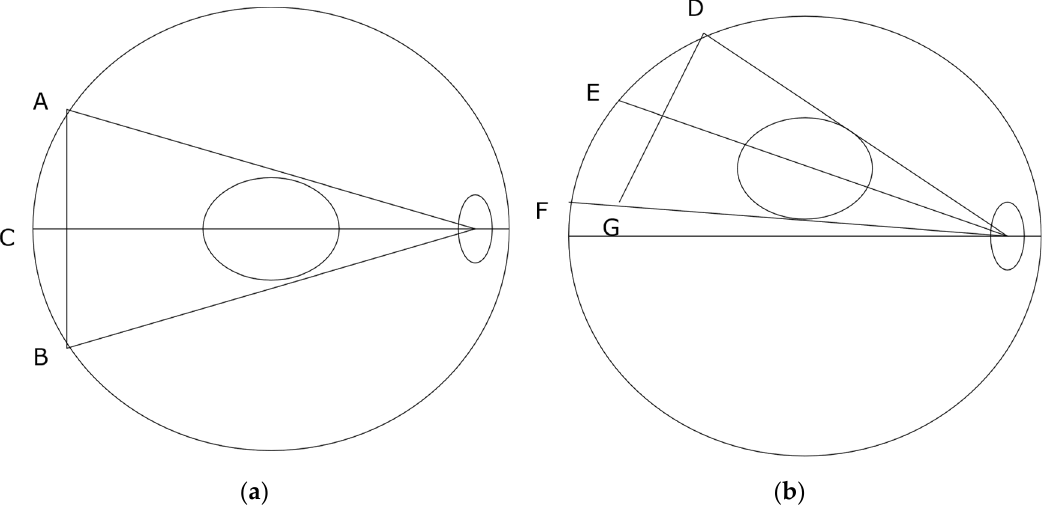
Figure 7. Schematic lateral projections (LAT); ( a ) Phantom is at iso-center position: ˆ ACB is a curved projection plane and AB is a flat projection plane; ( b ) Phantom is at an off-center position: ˆ DEF is the curved projection plane and DG is the flat projection plane.